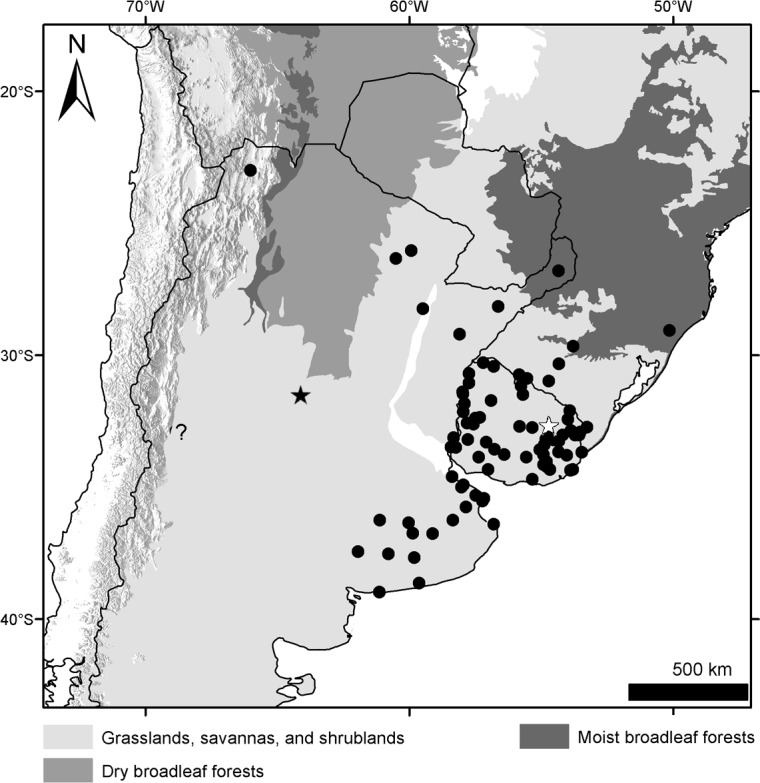
Localities recorded for Dasypus septemcinctus hybridus (dots) and D. s. cordobensis (star).Question mark: doubtful record from Mendoza. White star represents the type locality of D. s. hybridus.